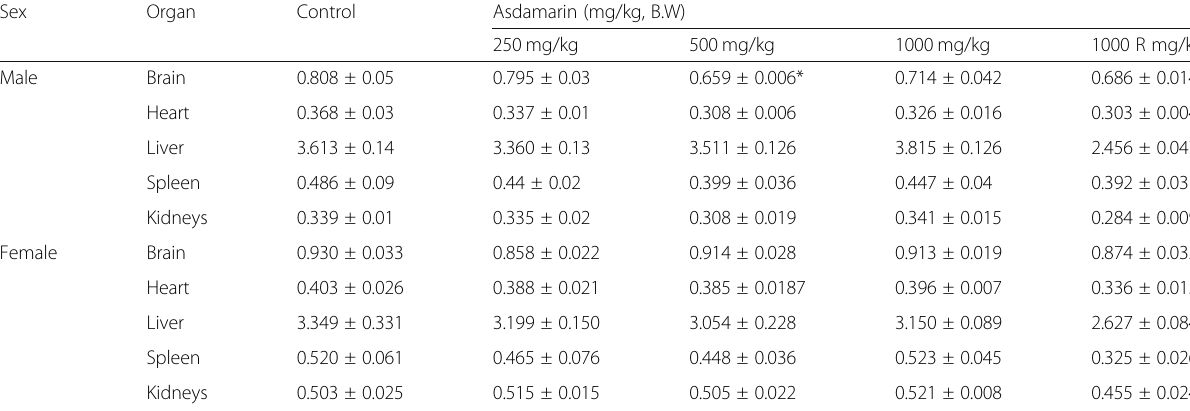
Values are expressed as mean±s.e.m. (n=10 for each group). * p <0.05 were considered significant using one-way Anova. * denote significant difference compared to control